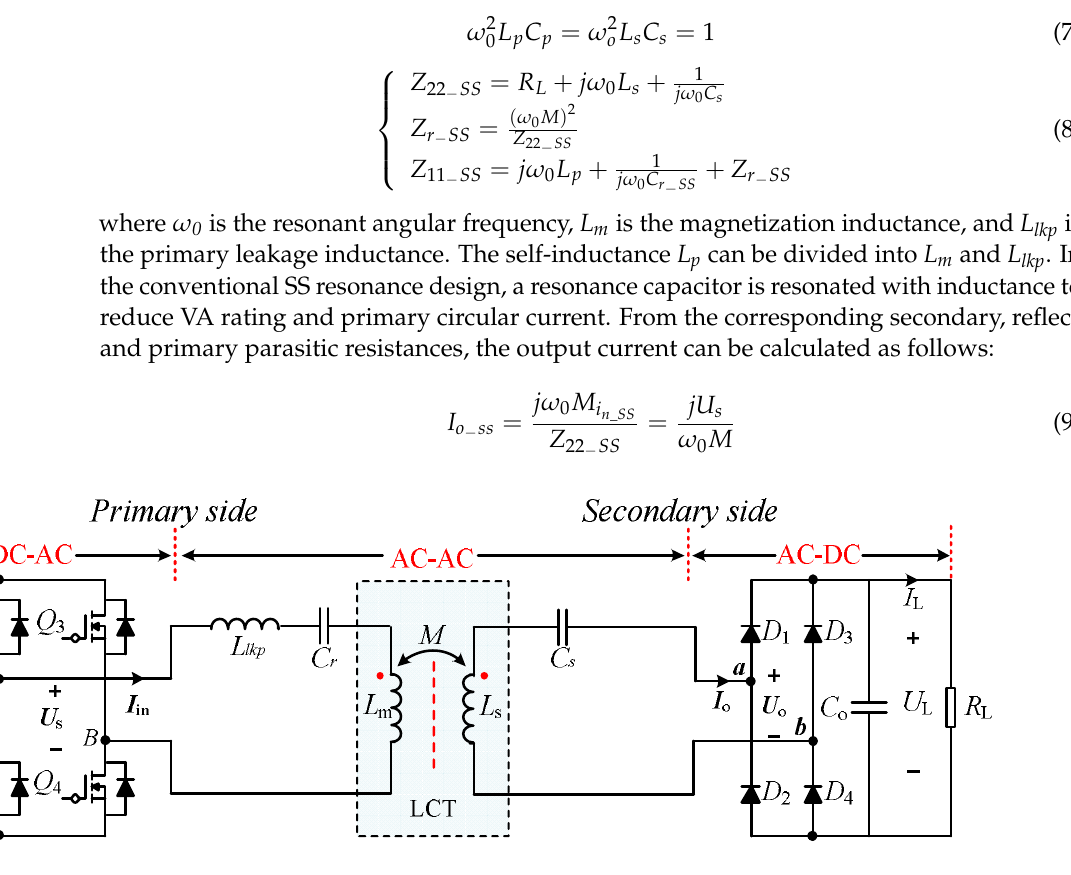
Figure 2. Proposed IPT compensation design method.